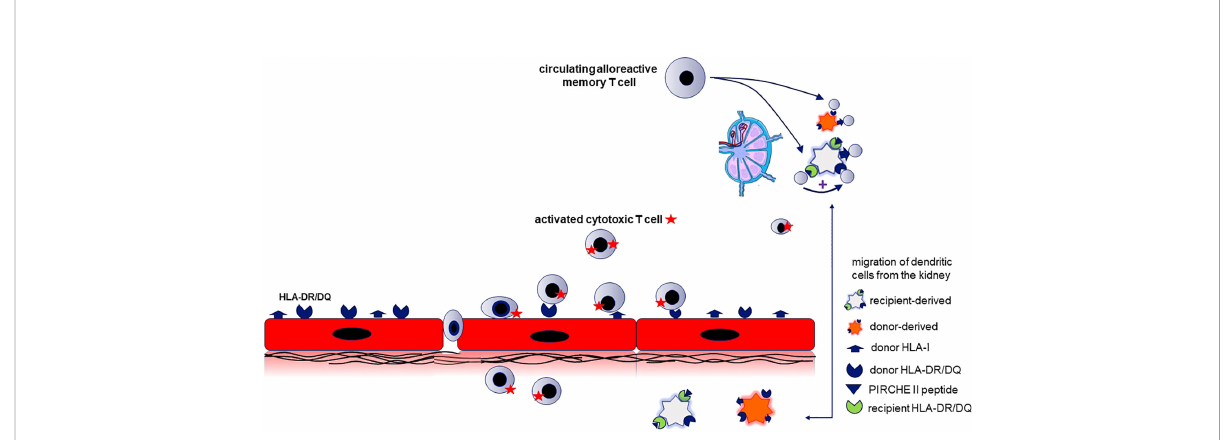
FIGURE 4 The relation between the PIRCH-II scores and acute vasculair rejection indicates that indirect antigen presentation of donor-derived MHC molecules potentiates the alloreactive cytotoxic T cell response. The mechanism proposed is semi-direct antigen presentation combined with direct antigen presentation. This requires that recipient dendritic cells (DC) cross-dressed with donor HLA-molecules (causing direct antigen presentation) is combined with indirect antigen presentation by the same DC to recipient T cells by via immunogenic donor HLA-II peptides (predicted by the PIRCHE score) loaded on the recipient HLA-II molecules. Renal endothelial cells (in red) constitutively express HLA-I and -II and are the source for intact donor-derived HLA molecules and the donor HLA-derived peptides that can be presented by recipient HLA-II (PIRCHE-II peptide). The recipient kidney DC (light grey cell) loaded with donor HLA II peptides on their HLA II molecules migrates to lymphoid tissue and stimulates recipient CD4 + T cells (indirect pathway). When the recipient dendritic cell is simultaneously cross-dressed with intact donor HLA molecules, the indirectly activated CD4 + T cells can provide help for directly alloreactive recipient CD4 + or CD8 + T cells (known as the semidirect pathway). The indirectly activated recipient CD4 + T cells may also promote the activation of alloreactive T cells recognizing donor HLA on the donor kidney-derived DC (direct pathway; orange cell). The activated alloreactive T cells attack the donor endothelial cells and migrate into the subendothelial tissue (vascular